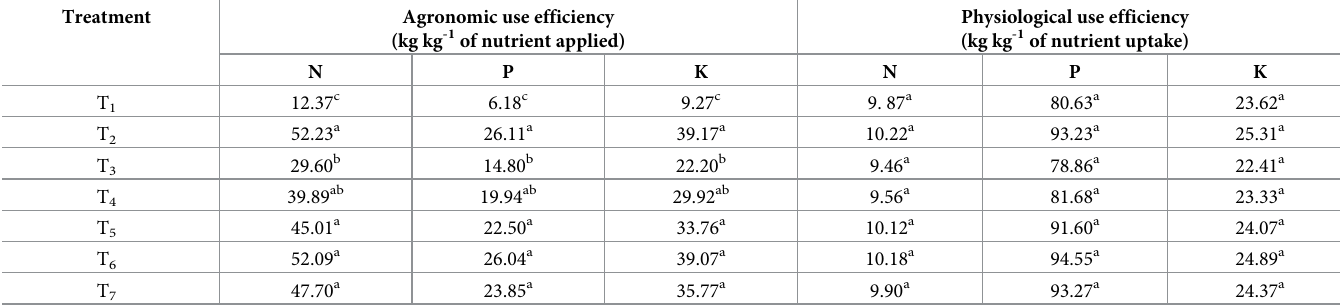
Table 6. Agronomic and physiological efficiencies influenced by weed management practices in soybean. Treatment